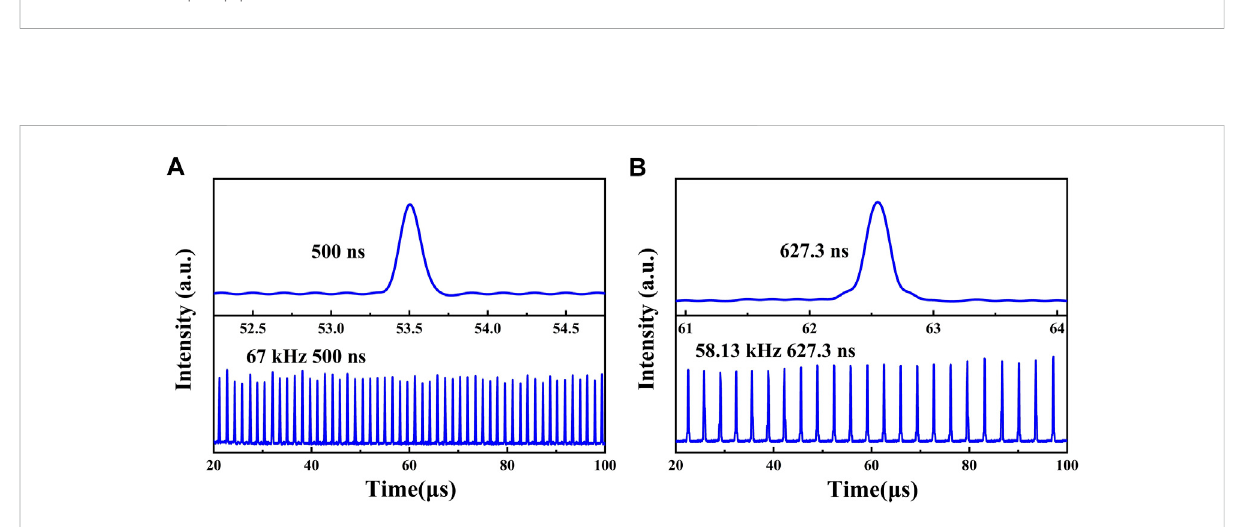
Typical pulse trains and single pulse pro fi les (A) T = 2%, (B) T =